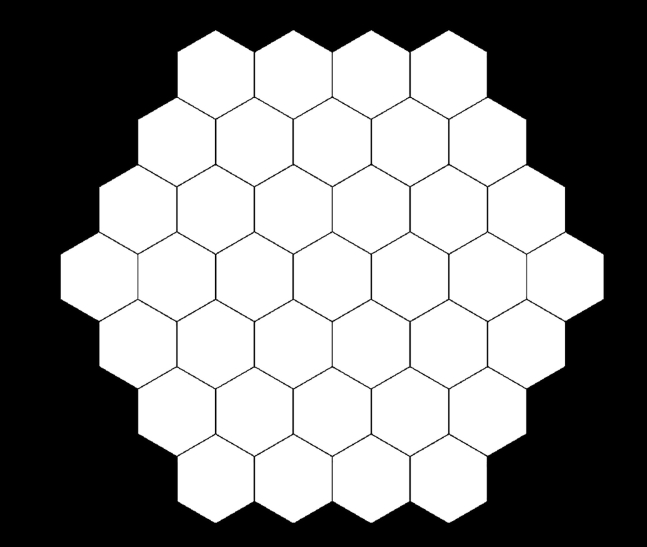
ROI masks composed of 37 500-μm center-to-center distanced hexagons